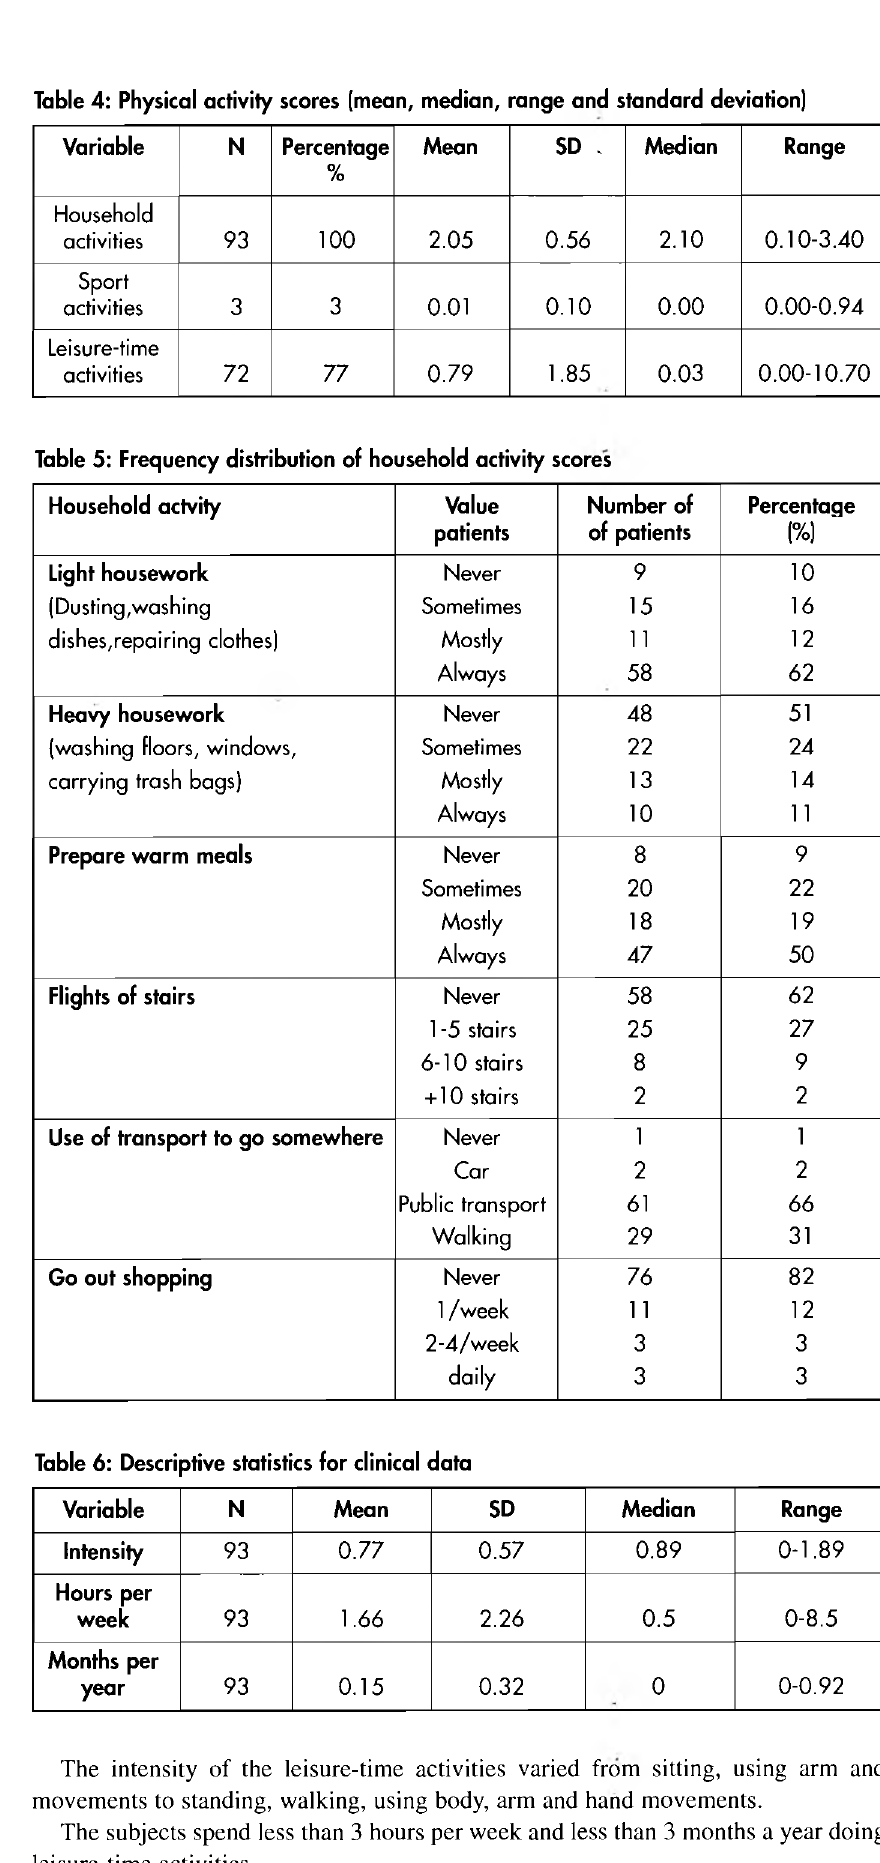
Table 6: Descriptive statistics for clinical